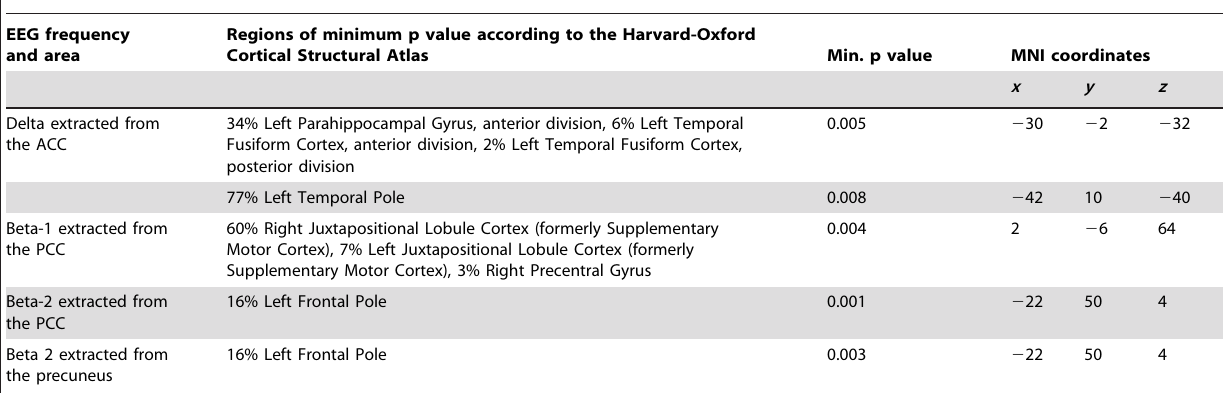
Figure 4. Statistical correlation maps of the EEG frequencies with the DMN signal. Significant voxels thresholded at p , 0.00833 for (a) delta-band extracted from the ACC (b) beta-1 frequency extracted from the PCC, (c) beta-2 frequency extracted from the PCC and (d) beta-2 frequency extracted from the precuneus. doi:10.1371/journal.pone.0088214.g004 Table 1. MNI coordinates of clusters with minimal correlation p values with the DMN signal. Structures defined according to the Harvard-Oxford Cortical Structural